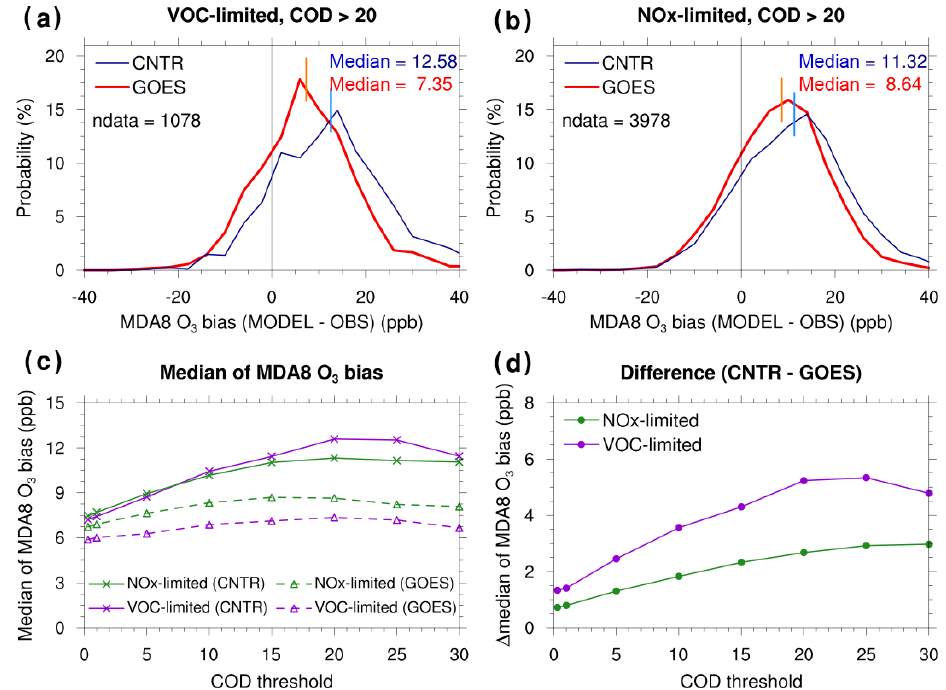
Figure 7. (a) Probability density function of maximum daily 8h average (MDA8) O 3 bias (model value minus observation value) for the VOC-limited regime under cloudy-sky conditions defined with a COD threshold of 20. (b) Same as (a) , but for the NO x -limited regime. (c) Median values of MDA8 O 3 bias with respect to COD threshold in the CNTR simulation (solid lines with cross marks) and in the GOES simulation (dashed line with triangles) for VOC-limited (purple color) and NO x -limited regimes (green color). (d) Difference in median values of MDA8 O 3 bias between the two simulations with respect to COD threshold (i.e., CNTR minus GOES).